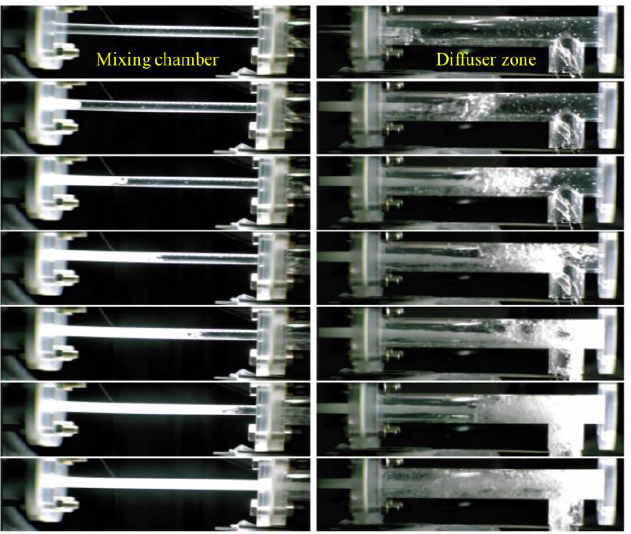
Figure 3. Flow visualization of cavitation flow generation resulting from the washing ejector at 5 MPa.